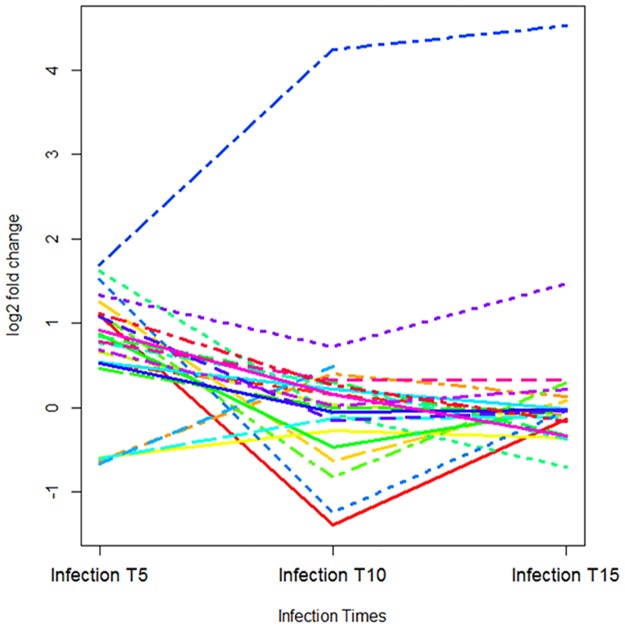
Expression profiles of the genes involved in the 'metabolic pathways'.The X axis shows the time points following infection (days 5, 10 and 15 P.I). On the Y axis, genes expression fold changes.